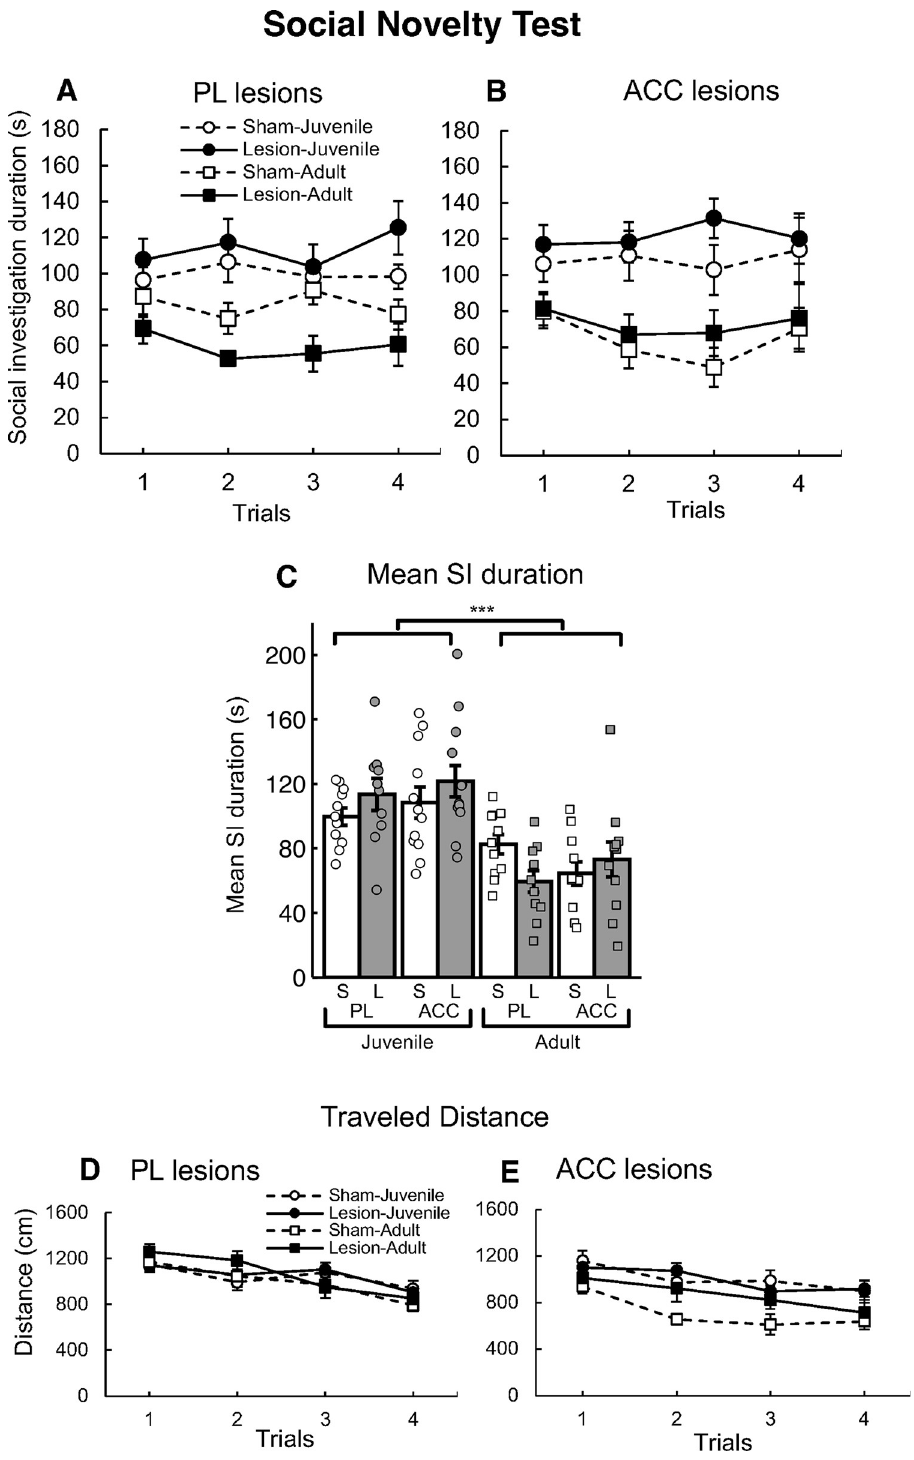
Fig 3. Results of the social recognition test (SNT) in the prelimbic cortex (PL)-lesioned and anterior cingulate cortex (ACC)-lesioned mice. (A) The mean social investigation (SI) duration in the PL lesion group-juvenile (•; n = 10), sham control group-juvenile ( � ; n = 11), PL lesion group-adult ( ■ ; n = 11), and sham control group-adult ( □ ; n = 11). (B) The mean SI duration in the ACC lesion group-juvenile (•; n = 13), sham control group-juvenile ( � ; n = 12), ACC lesion group-adult ( ■ ; n = 11), and sham control group-adult ( □ ; n = 11). The error bars indicate